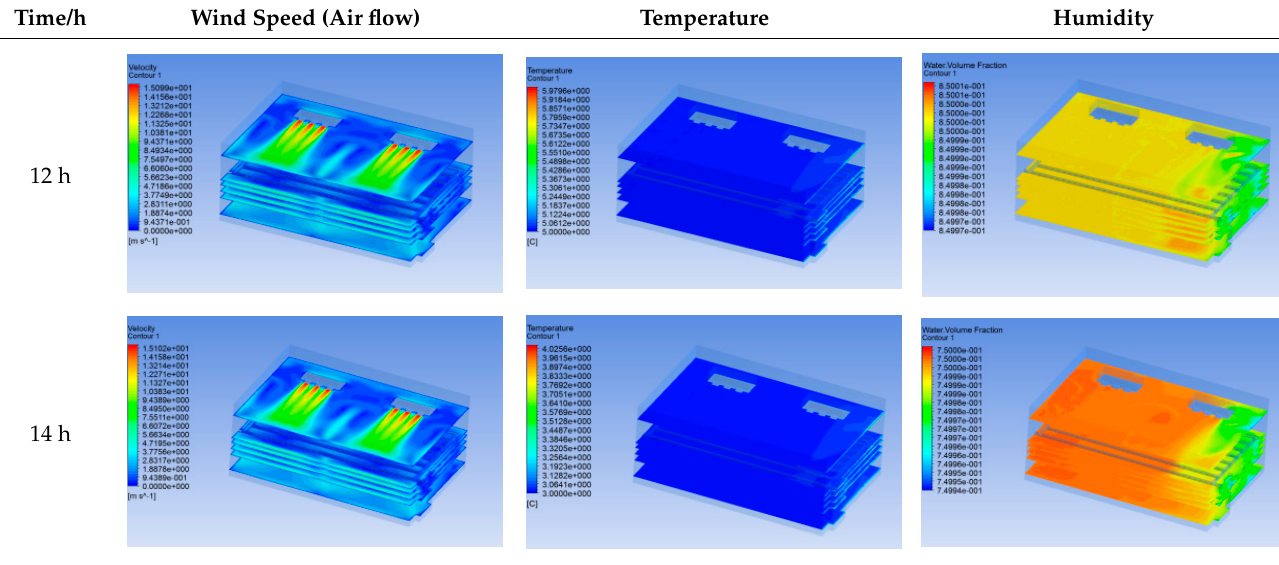
In the wind speed diagrams, different colors represent different wind speeds. The more biased the red color is, the higher the wind speed, and the more biased the blue, the lower the wind speed. Different colors represent different temperatures, and the more biased the red color iss, the higher the temperature, and the more biased the blue, the lower the temperature. The more biased the red, the higher the humidity, and the more biased the blue, the lower the humidity.